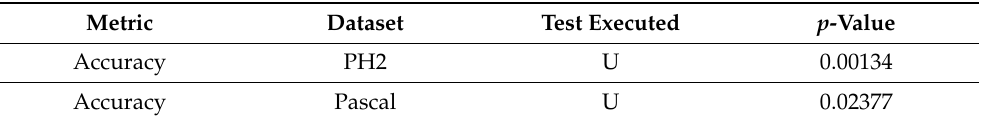
Table 15. Results of the Mann–Whitney U hypothesis